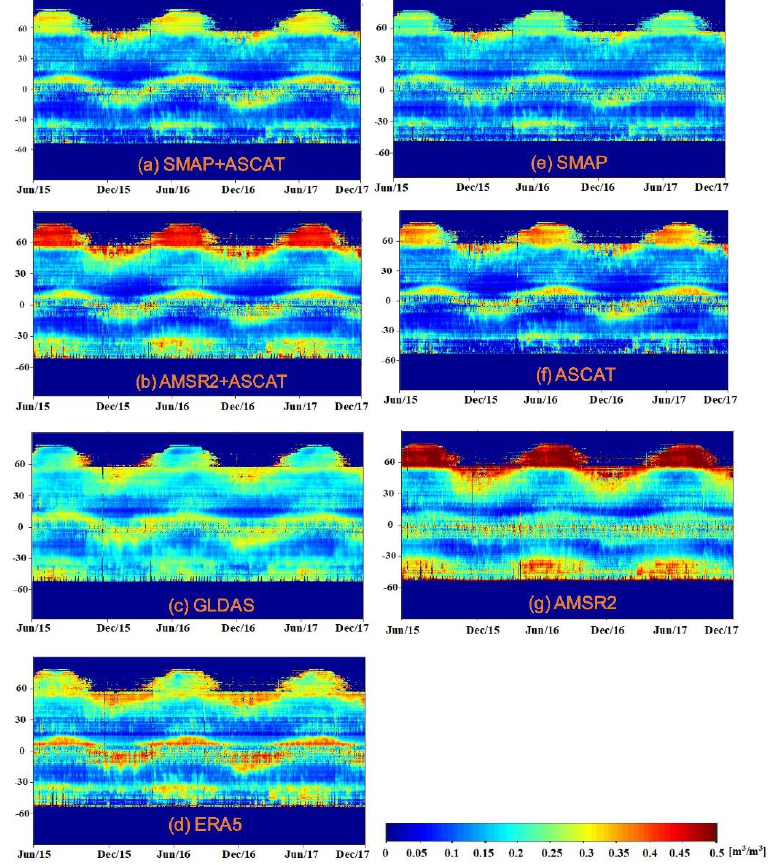
Figure 4. Hovmöller diagrams of merged and parents SM datasets in the period from June 2015 to December 2017: ( a ) SMAP+ASCAT; ( b ) AMSR2+ASCAT; ( c ) GLDAS; ( d ) ERA5; ( e ) SMAP; ( f ) ASCAT; and ( g ) AMSR2.